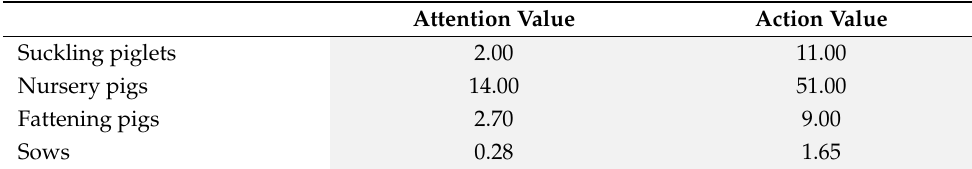
Table 1. Benchmarking values of the BD100 for the different animal categories (adapted from AMCRA) [30]. To raise pigs according to RWA criteria, the BD100 had to be below the attention value for at least three out of four animal categories.